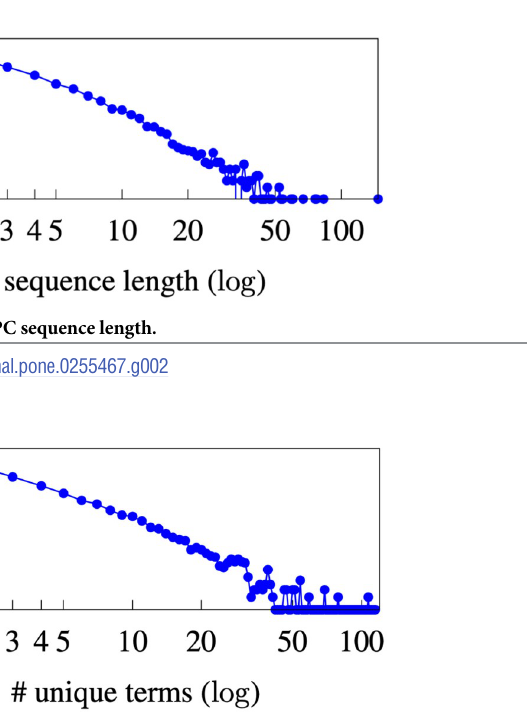
Fig 3. Distribution of INPC # unique terms per patient.